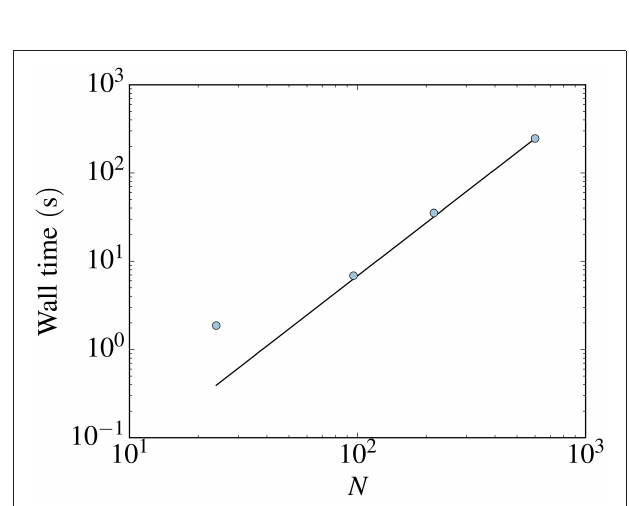
FIGURE 12 | Wall clock time time required to simulate the Haines jump case with the semi-implicit method for different network sizes. All simulations were run at Ca ∼= 10 − 7 and N denotes the number of nodes in the network. The wall time is seen to increase proportionally to N 2 for the three largest